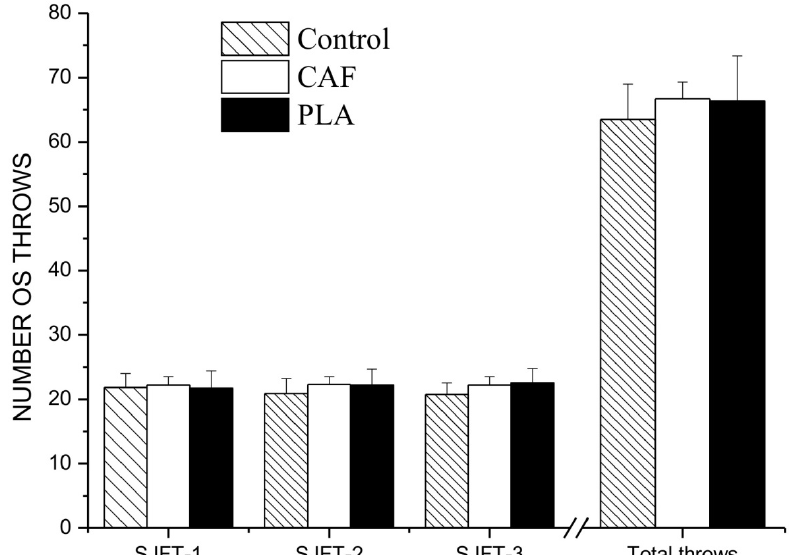
Figure 2. Number of throws in each bout of special judo fitness test (SJFT) in control, and after a 5-day weight-loss period followed by caffeine (CAF) or placebo (PLA). Data are expressed as the mean ± SD.